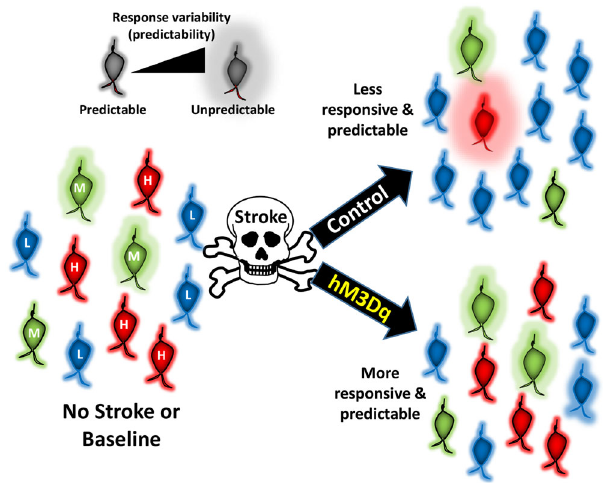
Fig. 7 Summary diagram showing the effect of stroke and chemogenetic stimulation on VIP interneuron responses. After stroke, there are fewer highly (H) responsive neurons and more minimal/low (L) responsive neurons in the peri-infarct cortex and their response became less predictable. Chemogenetic therapy preserves both the proportion and predictability of highly responsive neurons in peri-infarct cortex. M refers to moderately responsive